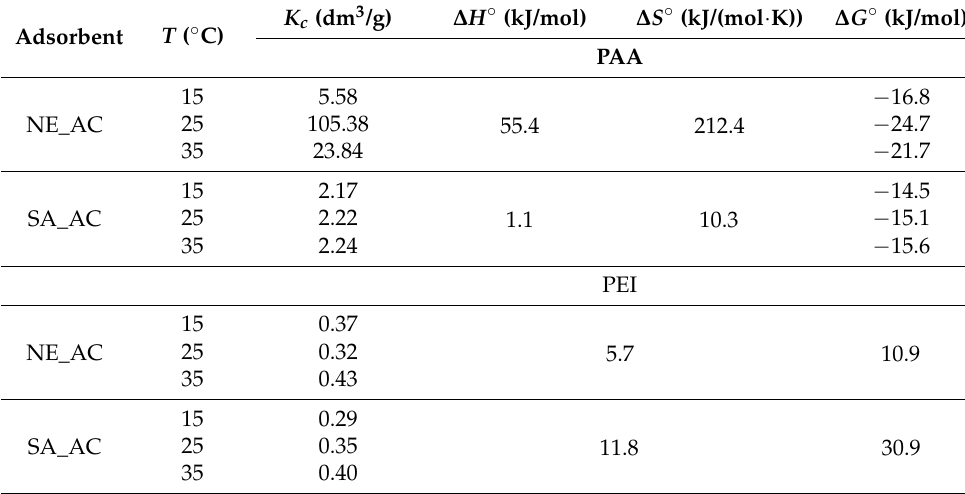
Table 5. Thermodynamic parameters of PAA and PEI adsorption on activated carbons